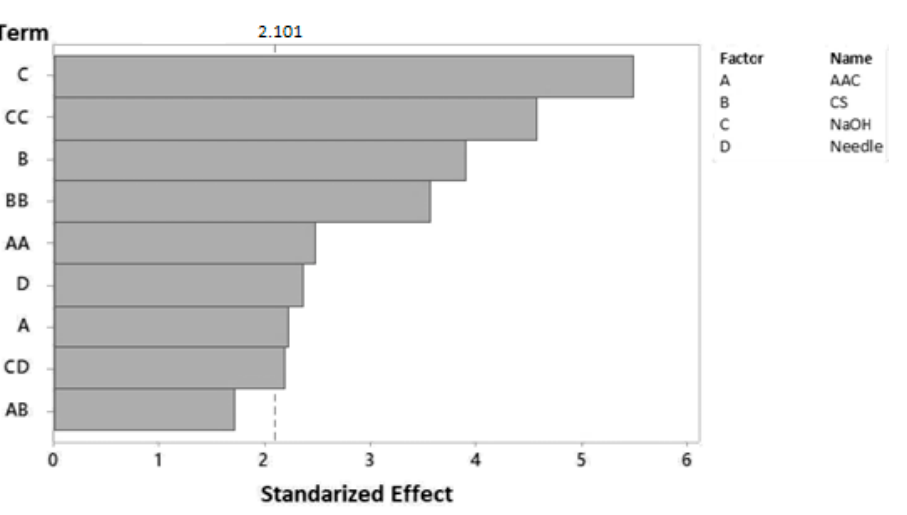
Figure 2. Pareto chart of the standardized effects. Response: Diameter. R.H. 10% ± 0.1%.